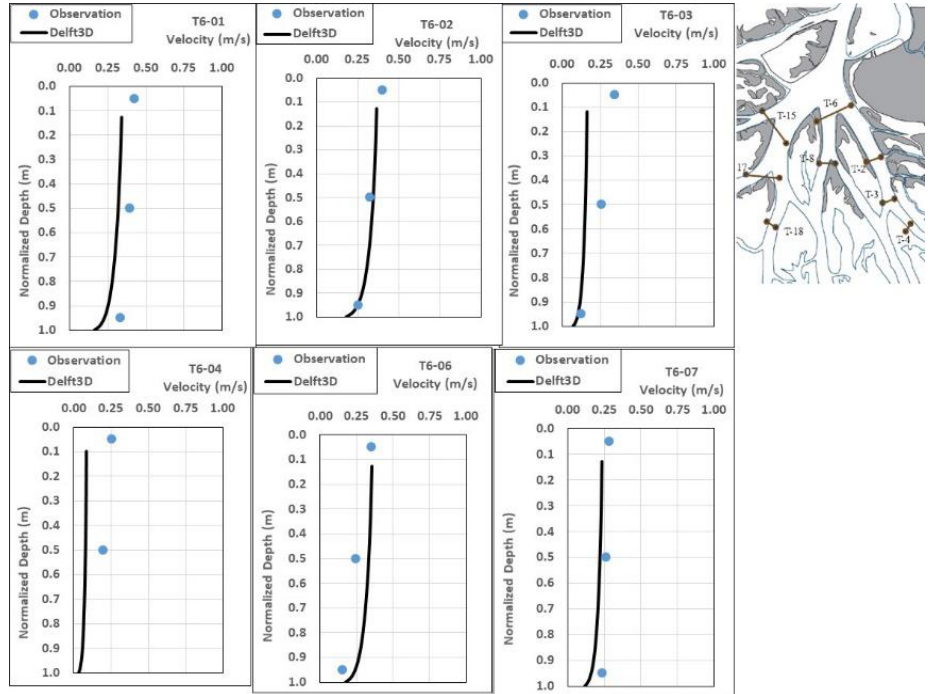
Figure 7. Validation results showing comparison of modeled and observed streamwise velocities upstream of East Pass, Gregg Pass, and Pintail Pass.